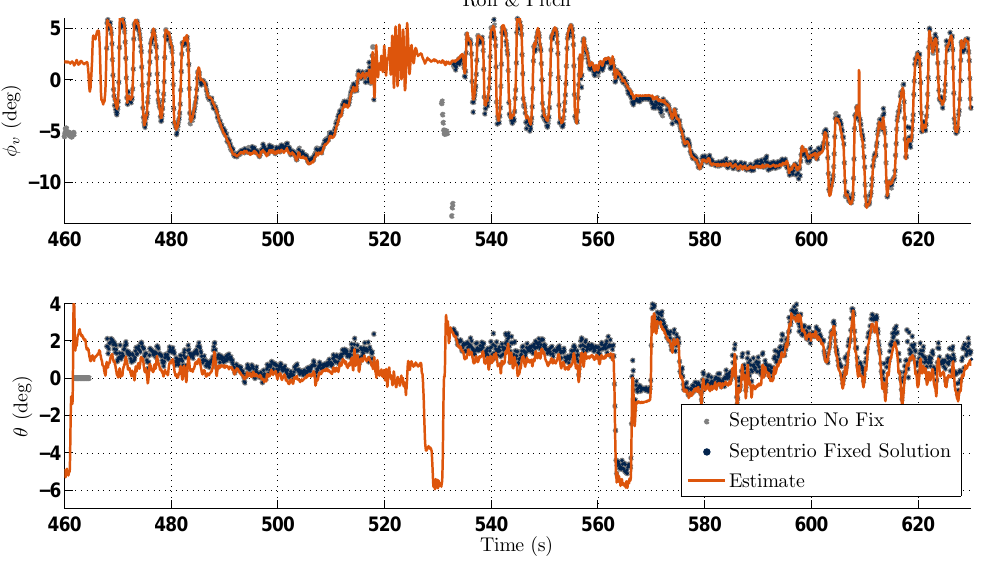
Figure 12. Roll and pitch comparison on the NCAT oval track 16-state coupled EKF .